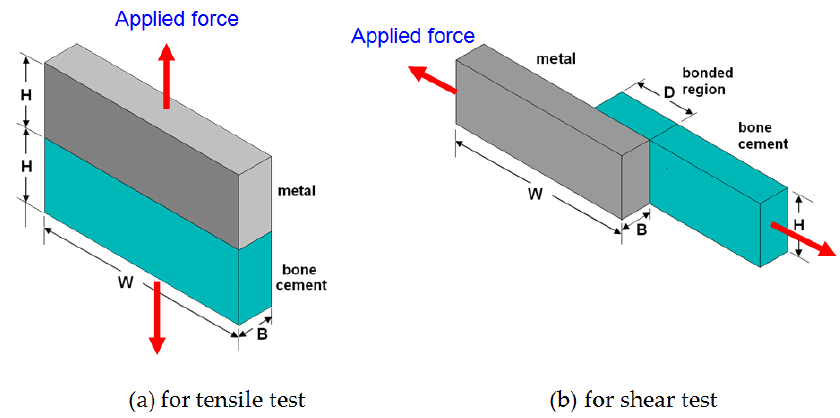
Figure 1. Geometry dimensions of metal/cement specimens and testing configuration for tensile and shear tests, respectively. (W = 30 mm, H = 10 mm, B = 5 mm, D = 10 mm).